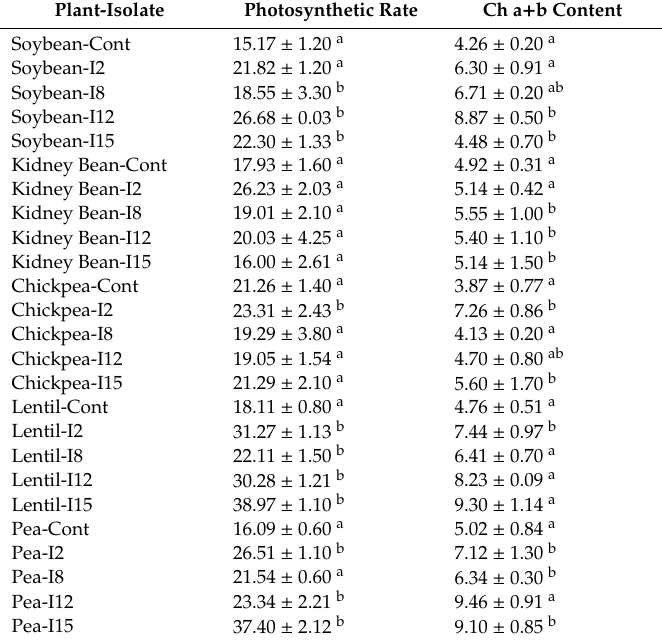
Table 3. Changes in photosynthetic rate ( µ mol CO 2 m − 2 s − 1 ) and chlorophyll a + b content (mg / g FW) in soybean, kidney bean, chickpea, lentil, and pea under control (cont.) and after enrichment with biologically active actinomycete isolates. Values are the average of three individual replicates (means ± S.D). Di ff erent letters represent significant di ff erences between the treatments in each crop (Duncan test; p < 0.05; n = 4).